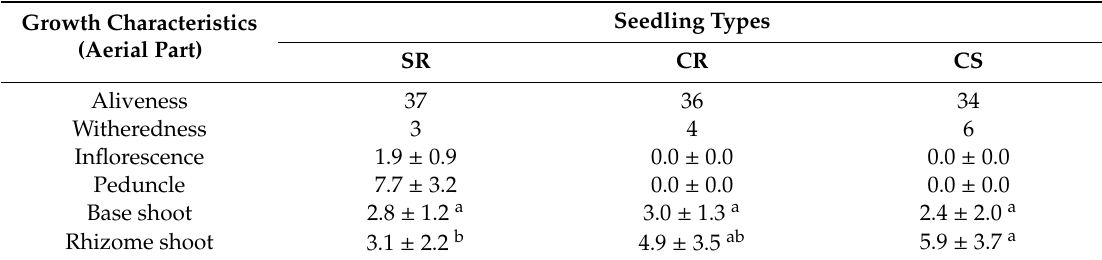
Figure 2. Comparison of the development of the aerial parts (number of leaves, leaf width, and leaf length) of three types of R. glutinosa seedlings (SR, CR, and CS). The indicated statistical differences were calculated using two-way ANOVA and Bonferroni’s post-hoc test: * p < 0.05, *** p < 0.001. N = 5. Table 1. Comparison of survival tendencies and aerial part growth parameters measured for three types of R. glutinosa seedlings (SR, CR, and CS).